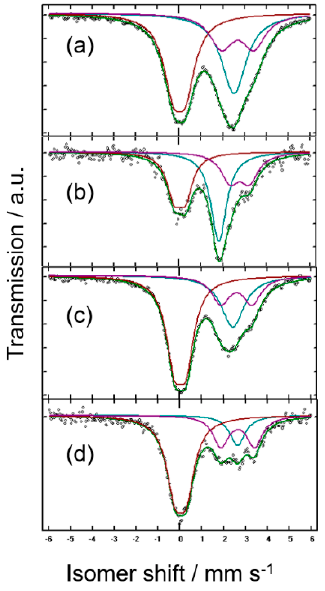
Figure 4. 119 Sn Mössbauer spectra of ( a ) Commercial nano-Sn, and ( b ) discharged nano-Sn electrodes in Mg half-cell to a Mg 1.3 Sn nominal composition. ( c ) discharged-charged nano-Sn electrodes in Mg half-cell to a Mg 0.4 Sn nominal composition. ( d ) discharged-fully charged nano-Sn electrodes in Mg half-cell.